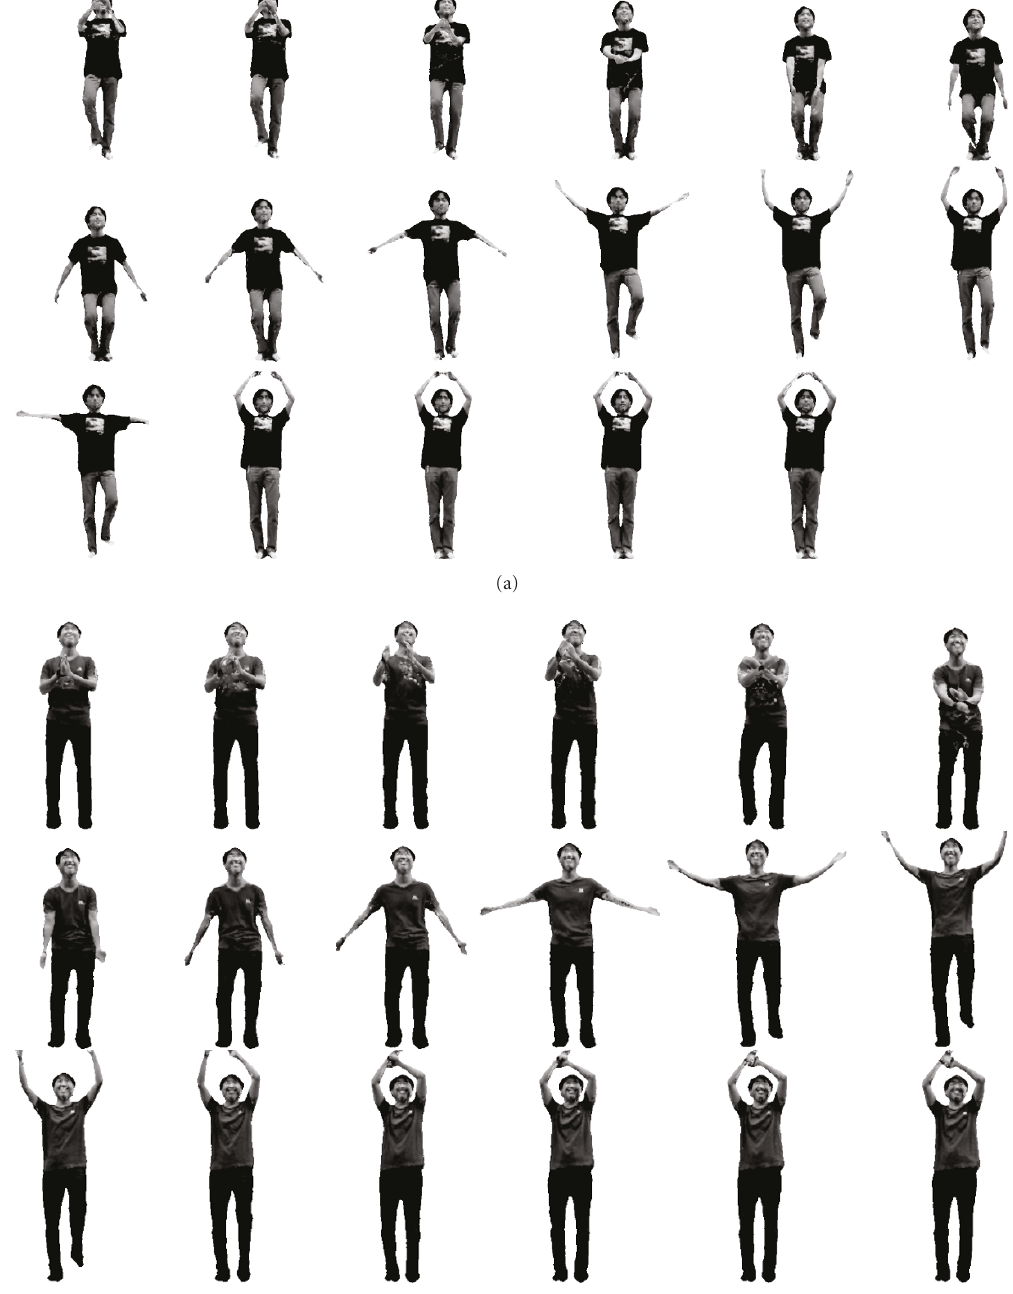
Figure 7: Clips of “draw a big circle”: (a) from #2-1, (b) from